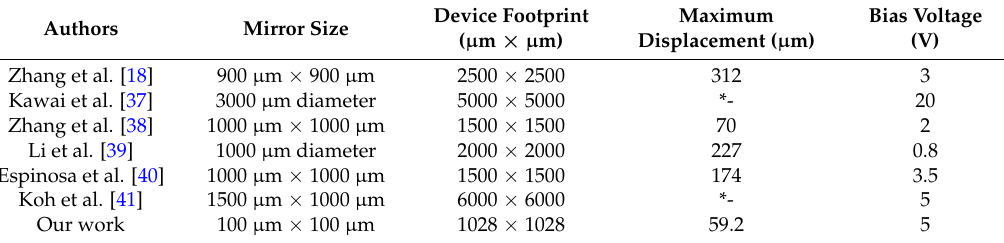
Table 3. Characteristics of several MEMS mirrors based on electrothermal